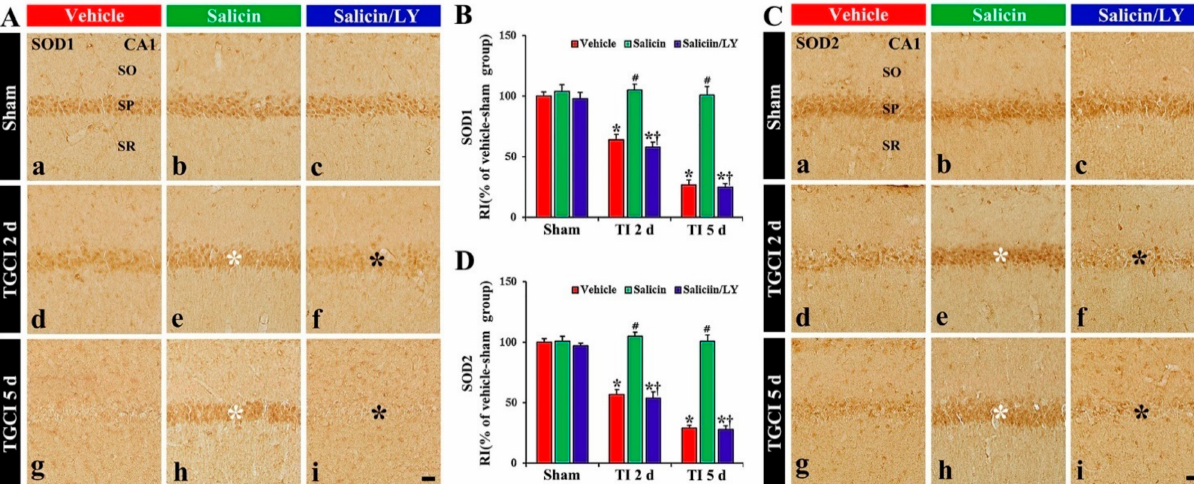
Figure 5. ( A , C ) SOD1 ( A ) and SOD2 ( C ) immunohistochemistry in CA1 of the vehicle-treated (left columns), salicin-treated (middle columns), and salicin/LY-treated (right columns) groups at sham ( Aa – Ac , Ca – Cc ), 2 days ( Ad – Af , Cd – Cf ), and 5 days ( Ag – Ai , Cg – Ci ) after TI. In the salicin-TI group, SOD1 and SOD2 immunoreactivity are not altered in CA1 pyramidal cells (white asterisks). However, in the salicin/LY-TI group, the two immunoreactivities (black asterisks) are significantly decreased similar to those in the vehicle-TI group. Scale bar = 50 µ m. ( B , D ) RI of SOD1 ( B ) and SOD2 ( D ) in the pyramidal cells. The bars indicate the means ± SEM ( n = 5 at each time, * p < 0.05 vs. each sham group, # p < 0.05 vs. vehicle-TI group, † p < 0.05 vs. salicin-TI group; the vehicle-sham group was regarded as control